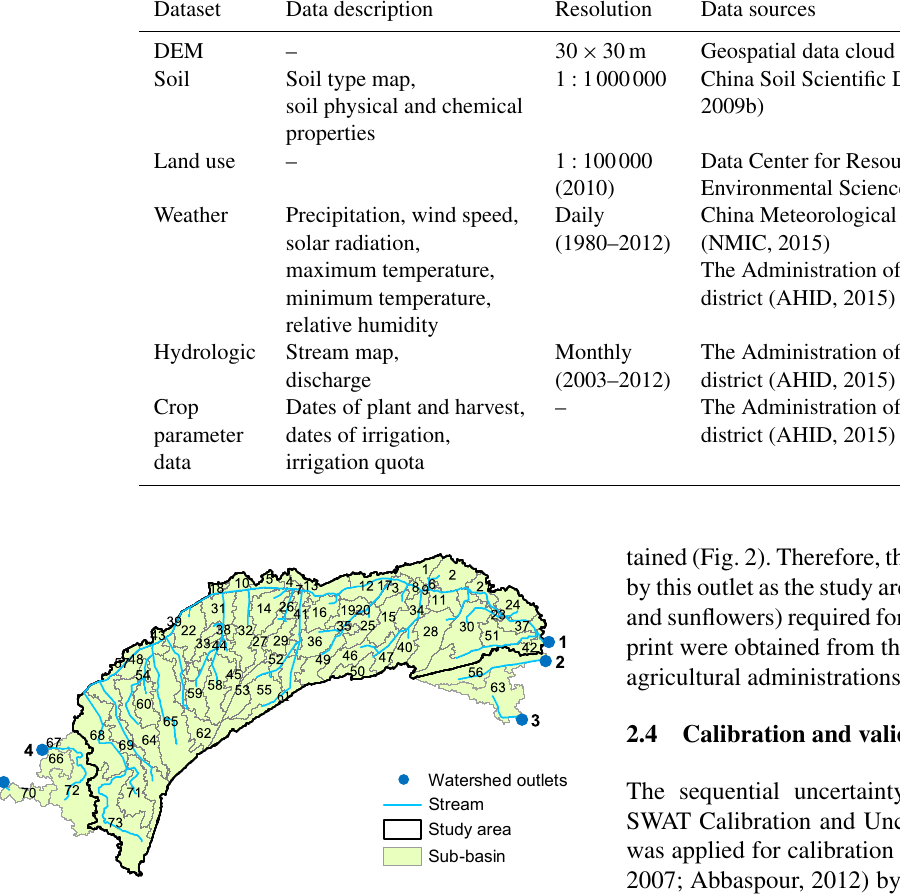
Figure 2. Sub-basins and study